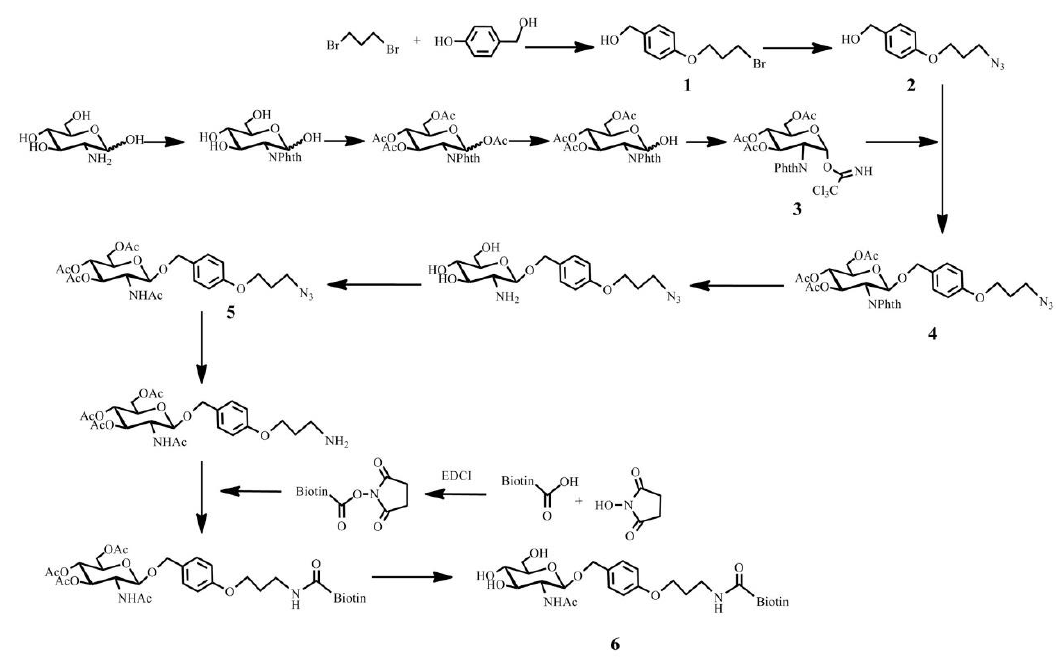
Table 1. Yields of three OPMEs by different